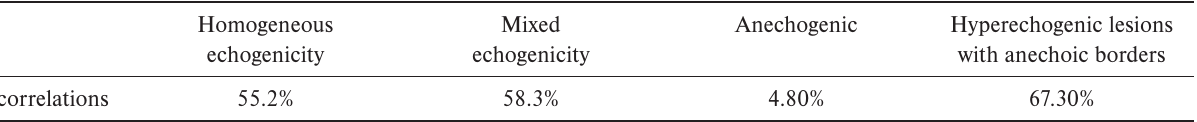
Table 6. Percentage correlations between ultrasound-predicted pathologies and histopathological